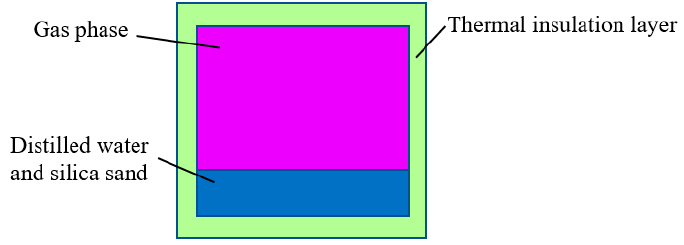
Figure 2. Conceptual model and discretization.